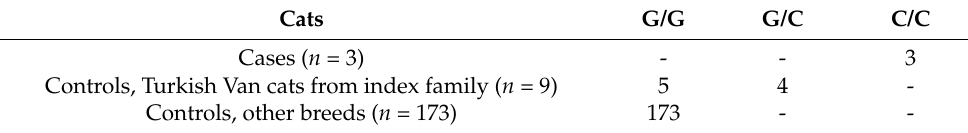
Table 2. Genotype–phenotype association of the SCL39A4 :c.1057G>C variant with AE. Cats G/G G/C C/C Cases ( n = 3) - - 3 Controls, Turkish Van cats from index family ( n = 9) 5 4 - Controls, other breeds ( n = 173) 173 -